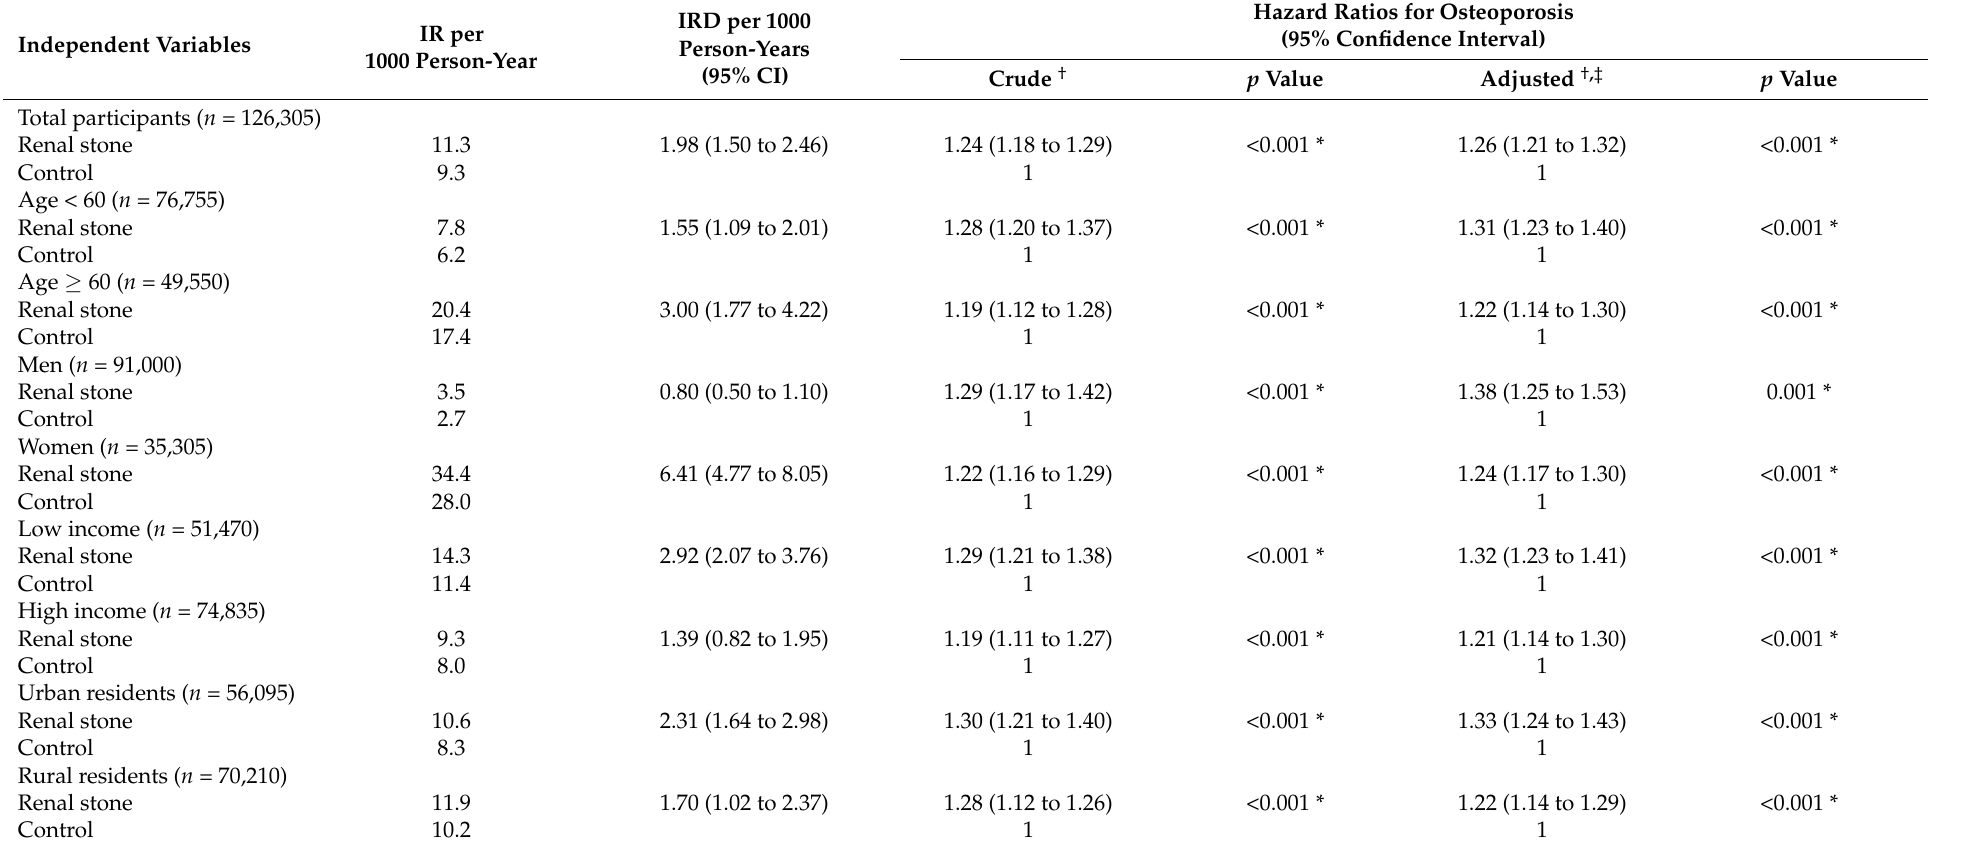
Table 4. Crude and adjusted hazard ratios of renal stones for osteoporosis stratified by age, sex, income, and